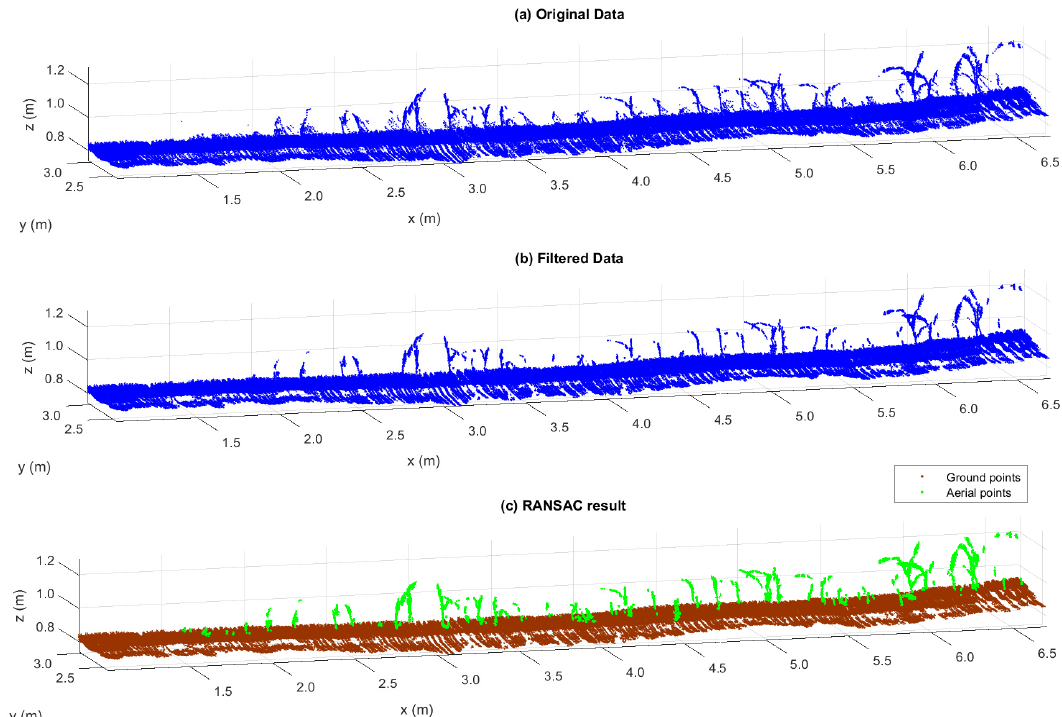
Figure 8. ( a ) Original point cloud; ( b ) filtered point cloud; and ( c ) RANSAC results during aerial point cloud extraction for the vertical LiDAR’s orientation when going at path 1 and row 2.